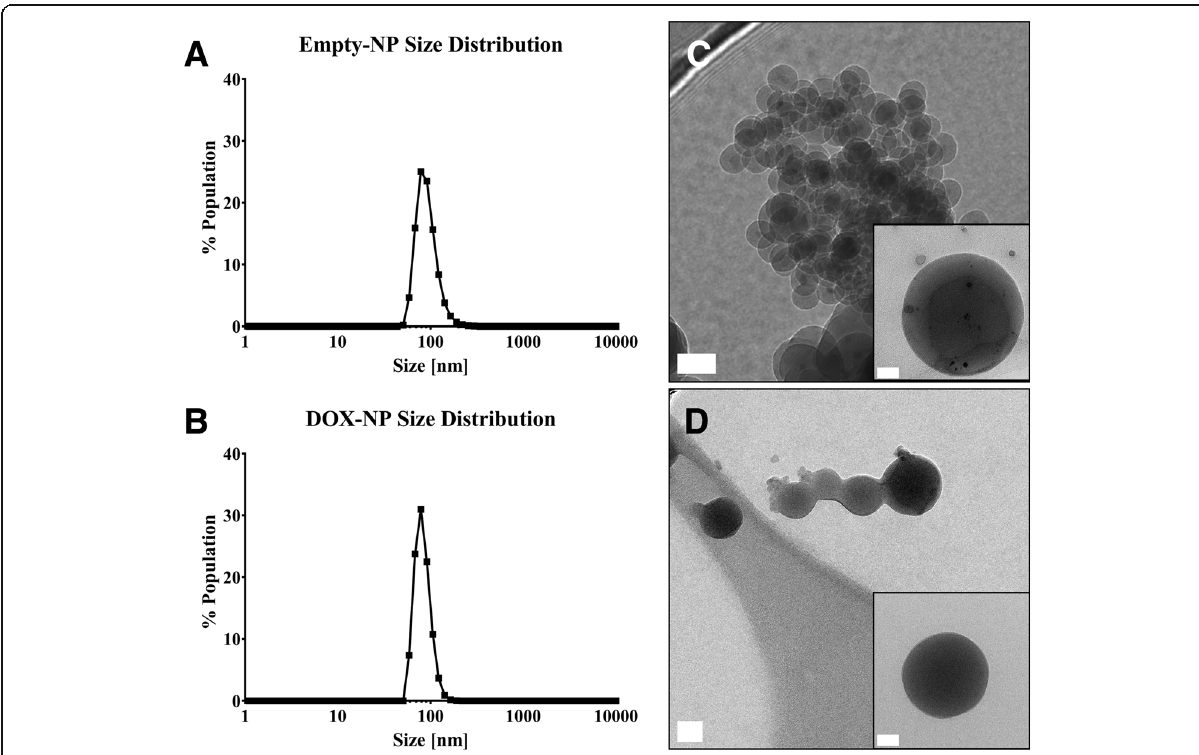
Fig. 2 Dynamic light scattering distributions of a NALG and b NALG-DOX show monodisperse distributions of alginate nanoparticles. Transmission electron microscopy images of c NALG and d NALG-DOX show spherical morphology of particles. Scale bars indicate 50 nm in larger picture, and 20 nm in